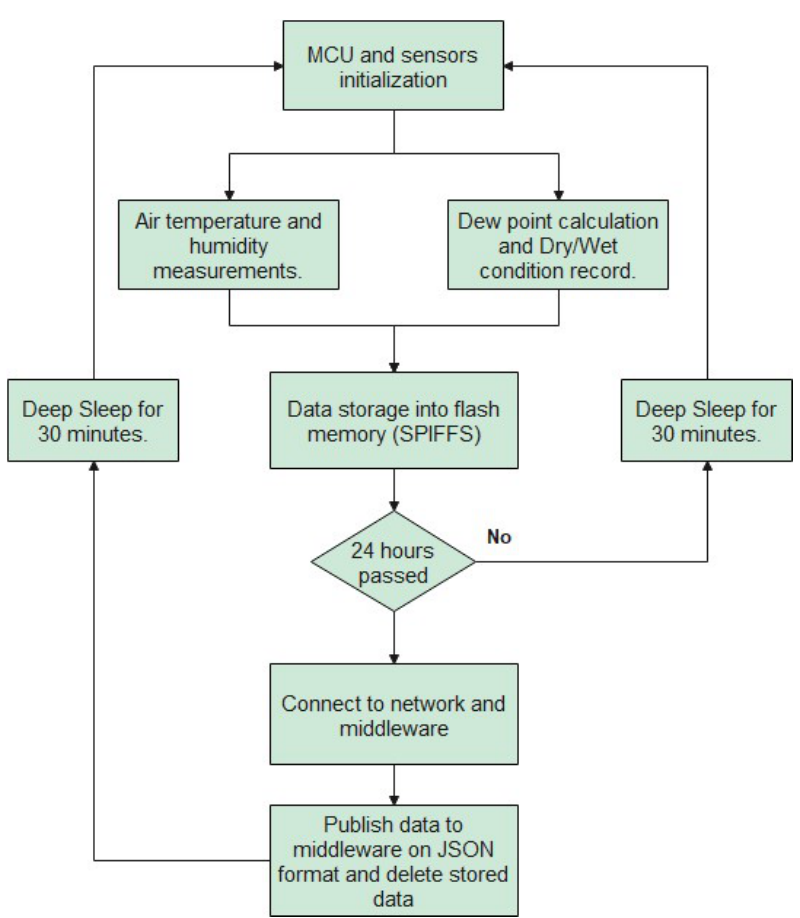
Figure 2. Process flow